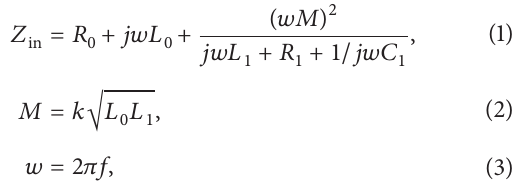
Figure 2: Change of coupling coefficient 𝑘 as a function of fre-